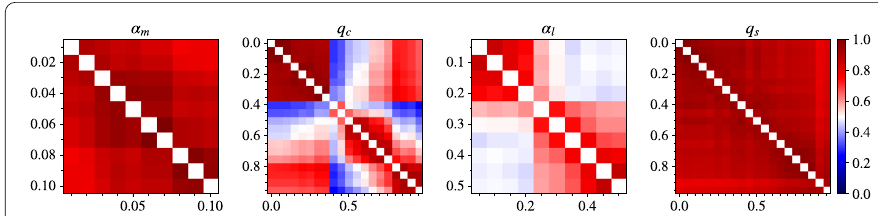
Figure 13 Pairwise NMI between the partitions of W ( c ) varying α m ( leftmost ) and varying the threshold quantile q c with α m = 0.01 ( middle-left ), and of W ( s ) varying α l with α m = 0.01, q c = 0.35 ( middle-right ) and varying the threshold quantile q s with α m = 0.01, q c = 0.35, α l = 0.2 ( right-most ), where the original measure is used and axis labels are shown in their